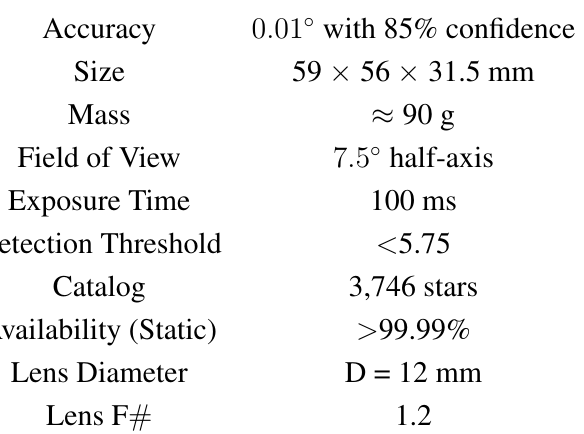
Table 1. Key ST-16 Specifications.